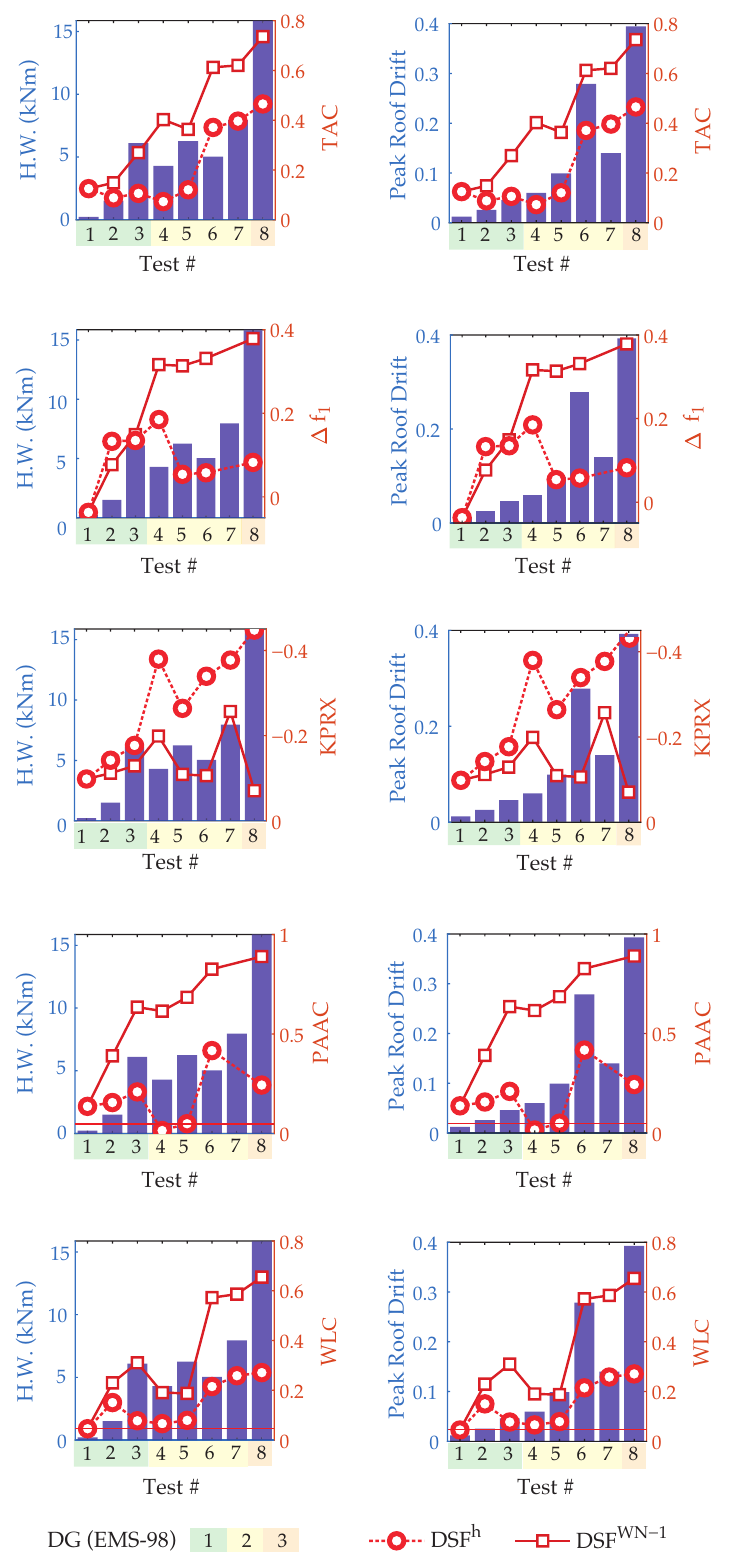
Figure 16. Comparison of acceleration-based DSFs with the hysteretic work ( left ) and peak transient roof drift ( right ) observed on the shake-table tests performed by Beyer et al. [90]. DSFs are represented for two changing reference conditions: healthy state and pre-earthquake